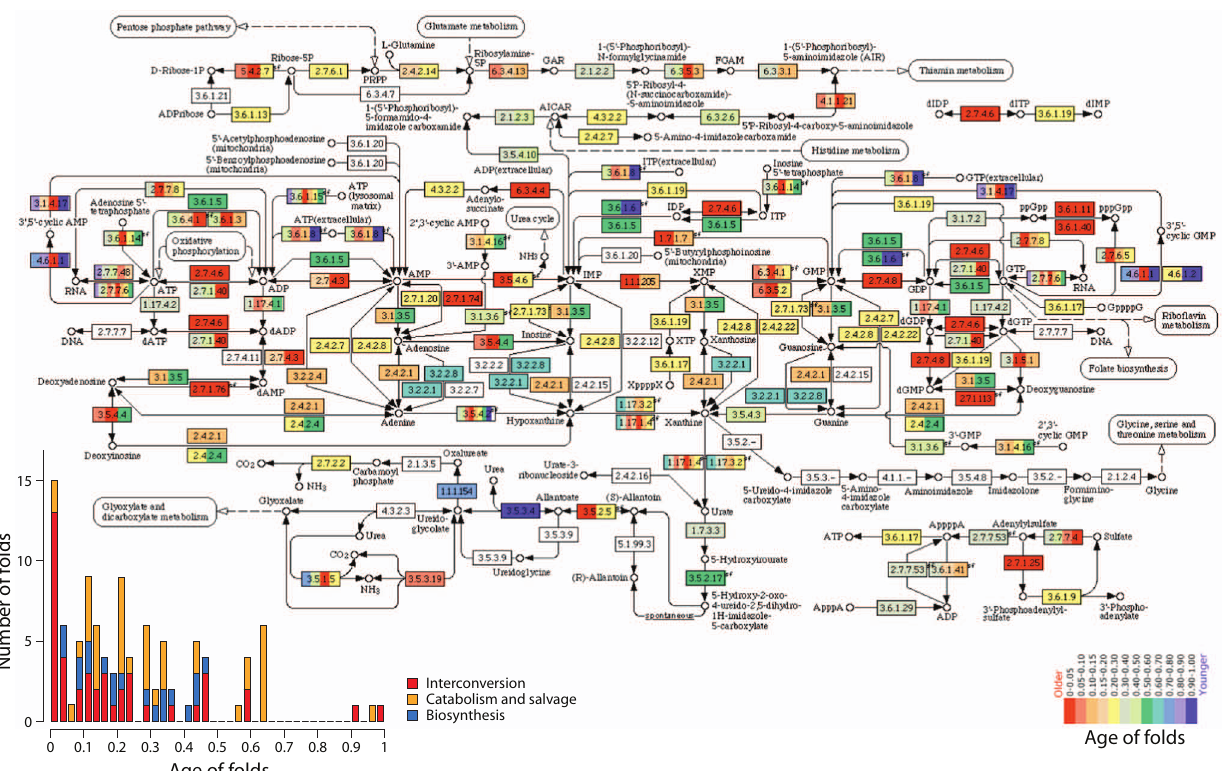
Figure 1. The purine metabolic subnetwork (NUC 00230) of MANET 2.0. Domain structures associated with individual enzymatic activities (described in EC nomenclature) are painted according to their age, in a scale of node distance ( nd F ) that ranges from 0 (the oldest enzymes) to 1 (the most recent). doi:10.1371/journal.pone.0059300.g001 lines [18,23]. These observations support the centrality of the purine metabolic network during the onset of early life.